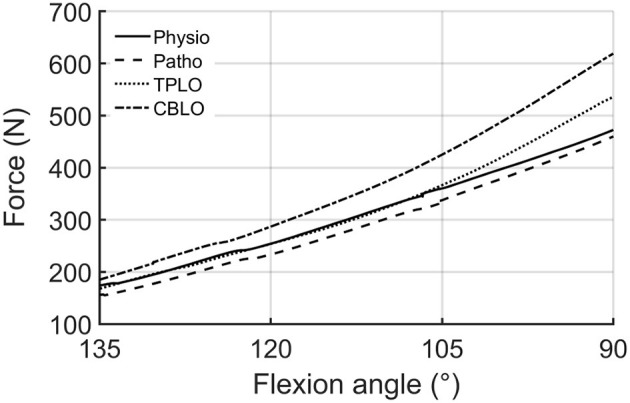
Patellar ligament reaction force measured during the squat simulation.